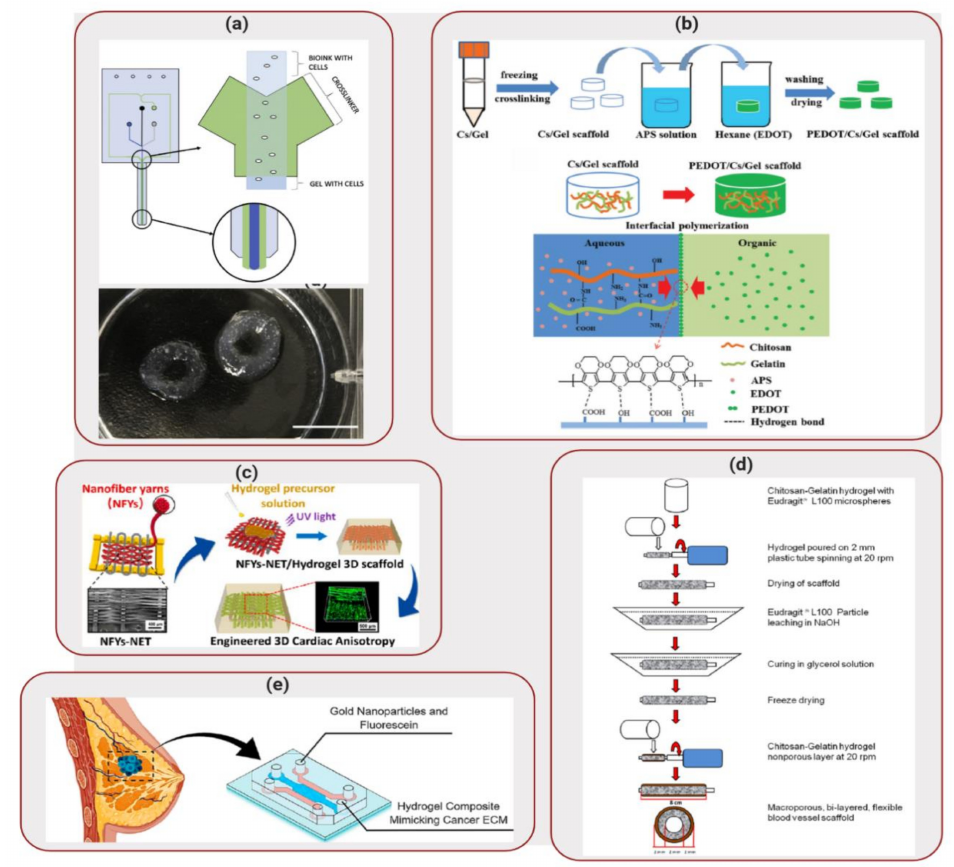
Figure 5. Applications of Biocomposites to Tissue Engineering: ( a ) Aspect biosystems’